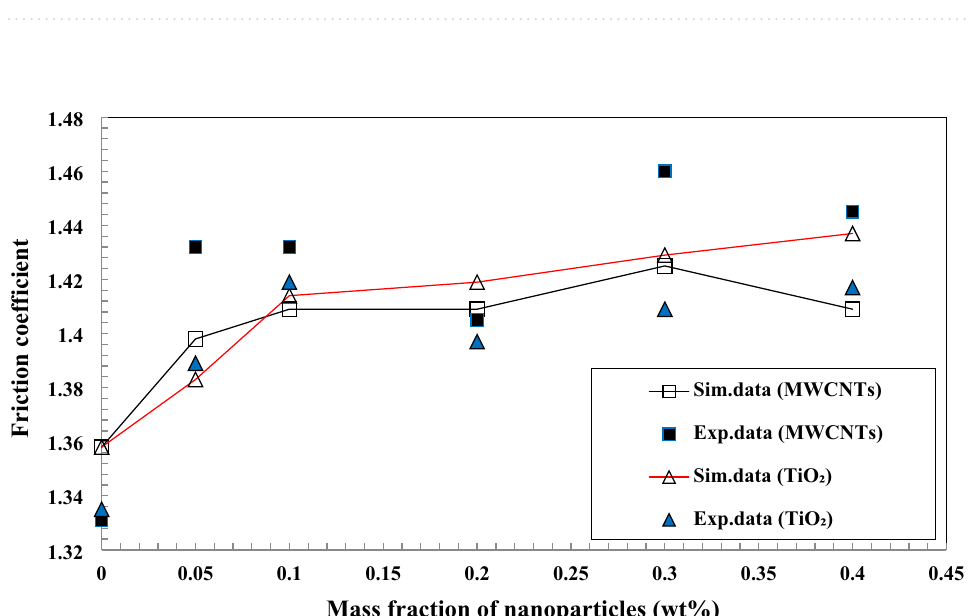
Figure 21. Comparison of experimental and simulation data of the average friction coefficient at the 0.069– 0.698 m/s velocity